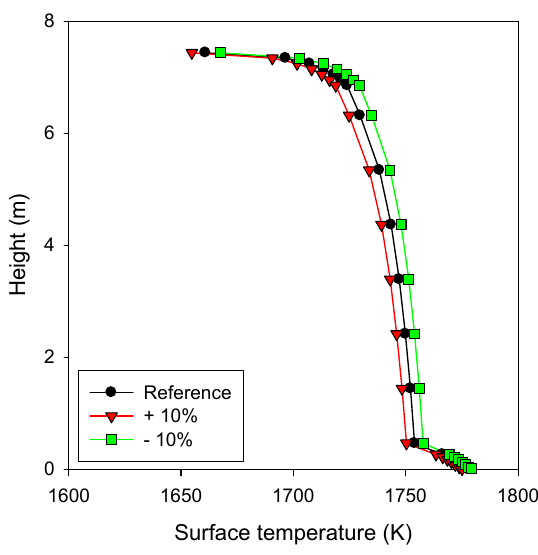
Figure 9. Effects of slag conductivity on surface temperature of liquid slag along the